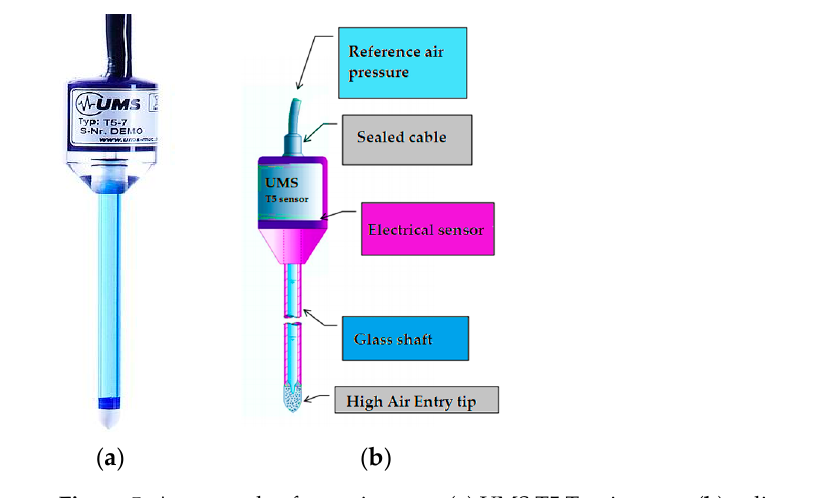
Figure 5. An example of a tensiometer: ( a ) UMS T5 Tensiometer; ( b ) a diagram of T5 [116].